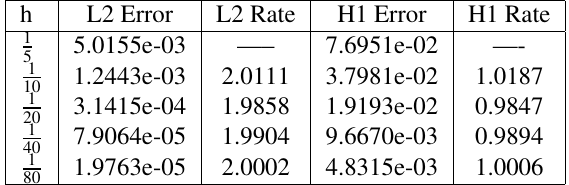
Table 5. Errors for Linear IFEM at final time for β + ( x ) = ( x + 1) 2 and β − ( x ) = x 2 + 1, ∆ t = h / 2 h